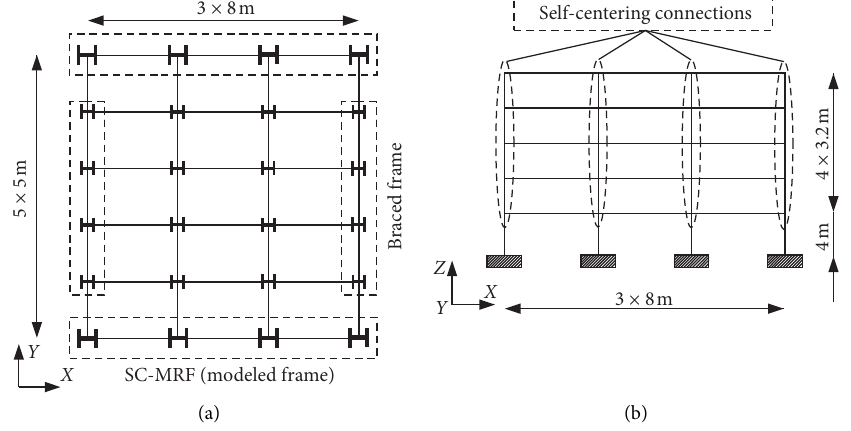
Figure 19: Arrangements of the SC mechanisms (adapted form [93]). (a) Plan view. (b) Elevation of an